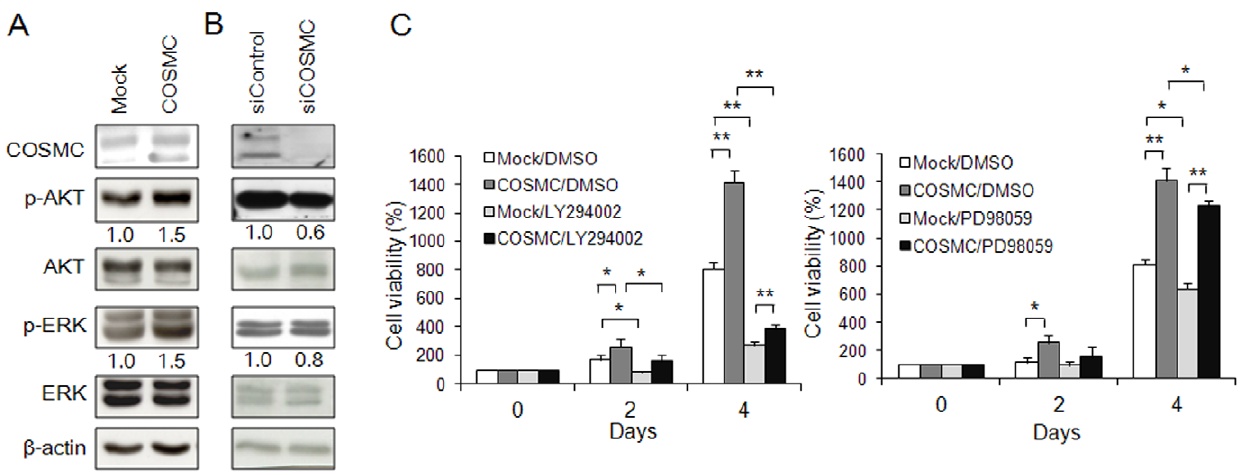
Figure 4. Roles of AKT and ERK signaling pathways in COSMC-enhanced cell proliferation. (A) COSMC overexpression enhances phosphorylation of AKT and ERK. Western blotting was performed to analyze protein expression. Representative images are presented. Relative intensity of signals was quantified by ImageQuant5.1 and shown. (B) COSMC knockdown inhibits phosphorylation of AKT and ERK. (C) Effects of AKT and ERK inhibitors on cell proliferation. HUVECs transfected with mock or COSMC plasmids were treated with DMSO control, 5 m M of LY294002, or 10 m M of PD98059. Cell viability was analyzed by MTT assays at different time points. Results are presented as means 6 SD from three independent experiments. * P , 0.05; ** P , 0.01.